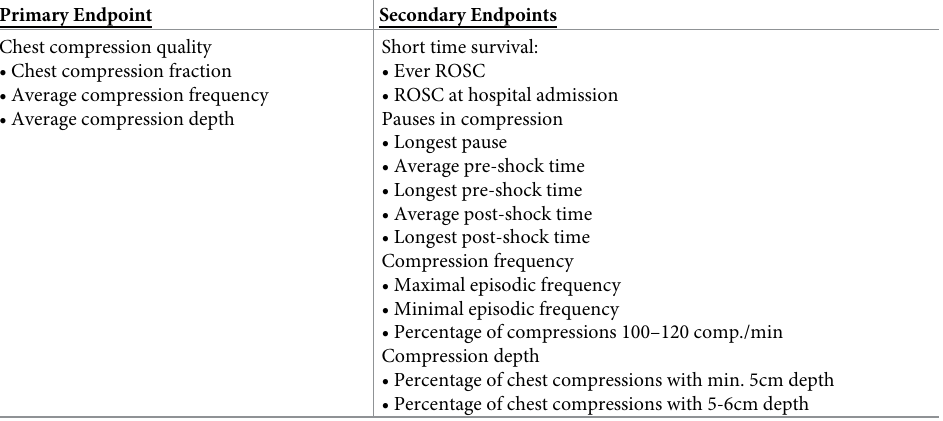
Table 1. Primary and secondary